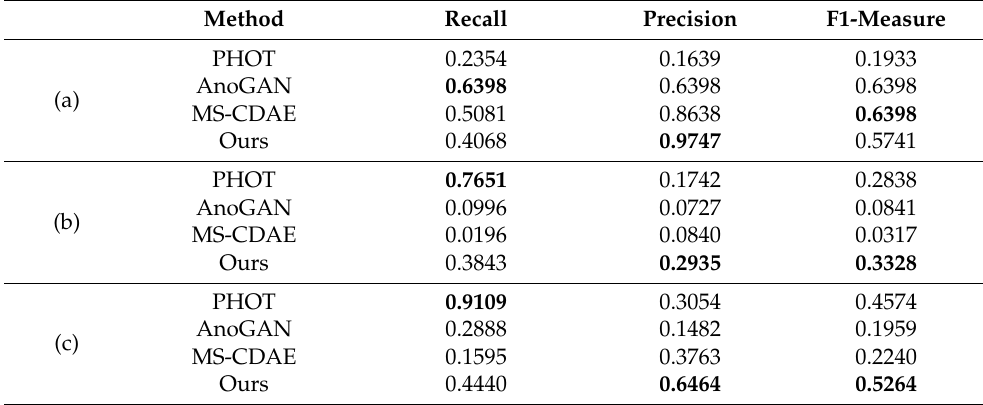
Table 5. Quantitative comparative results of Figure 8a–c between different methods.